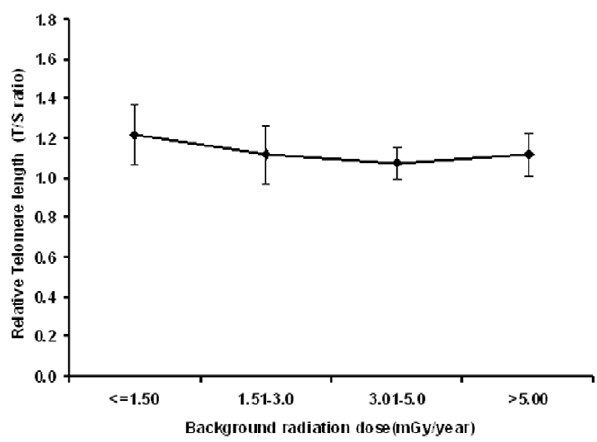
Figure 1. Telomere length in adults with respect to various background dose levels. (The line graph represents the relative telomere length (T/S ratio) in five different background dose groups ( # 1.5, 1.51–3.0, 3.01–5.0, . 5.00 mGy/year). For each point, error bars indicate the standard error of the mean (SEM). N (Number of individuals studied in each dose group) is given in table 1). age: 23.70 6 3.30 years) in females with an overall mean of 1.14 6 0.14 among all the individuals studied (mean age: 26.10 6 4.49 (range: 18 to 40 years). The values obtained in males was not statistically different from females (P . 0.05) (figure 2). No